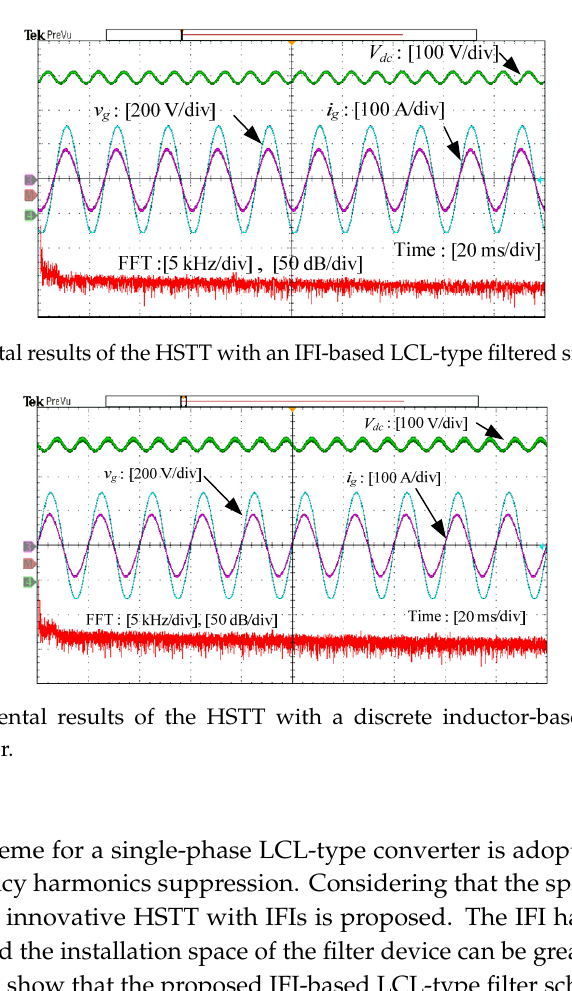
Figure 15. Photography of the experimental system.